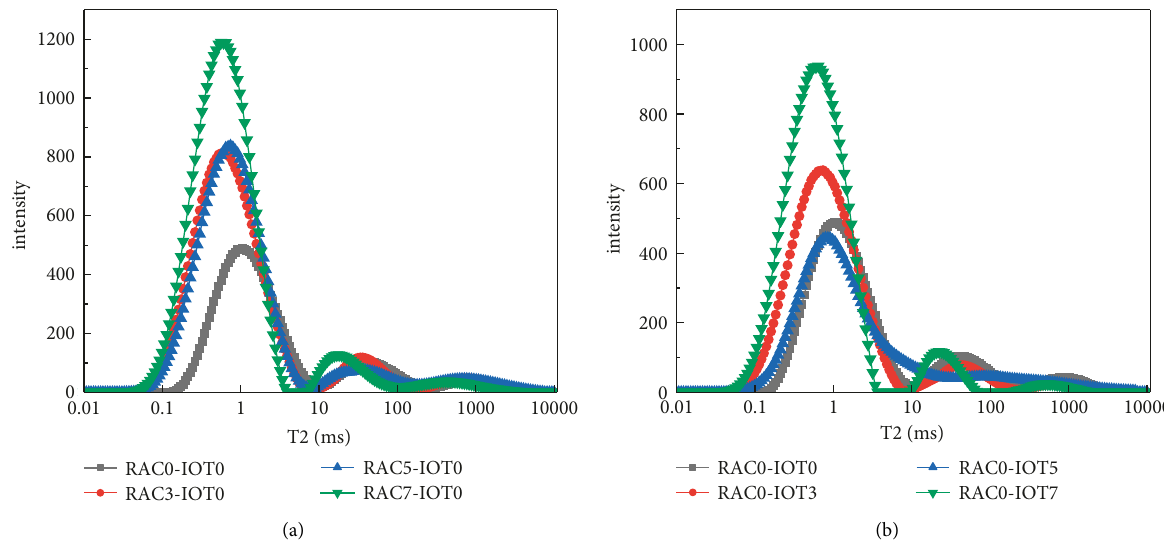
Figure 11: T2 Atlas before F-Tcycles with different mixing ratios: (a) the replacement rate of IOTis 0%; (b) the replacement rate of RCA is